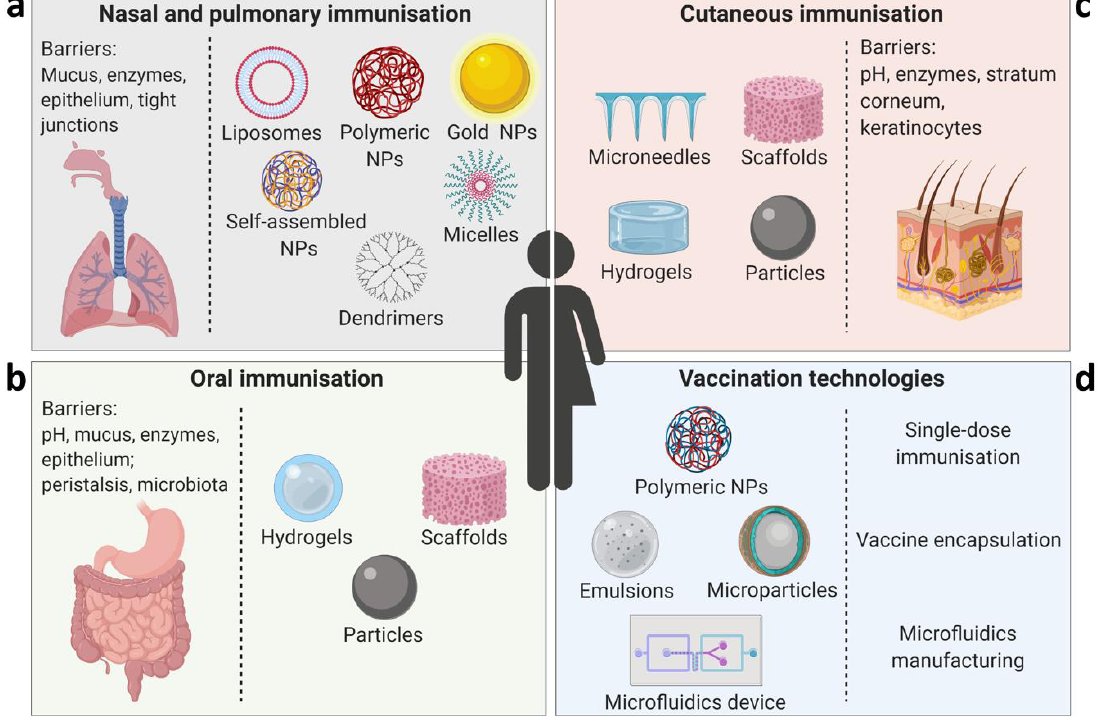
Figure 1. Advanced vaccination technologies and strategies for improving compliance and coverage. Key drug delivery systems to overcome barriers associated with each administration route are presented: ( a ) nasal and pulmonary immunisation using particulate delivery systems such as lipid-based systems (liposomes or nanocapsules), polymeric nanoparticles (NPs), gold NPs, self-assembled NPs (e.g., chitosan), dendrimers, and micelles; ( b ) oral immunisation using delivery systems such as hydrogels, scaffolds, and particles (nano- and microparticles); ( c ) cutaneous immunisation can be performed using microneedles, scaffolds, hydrogels, nano- and microparticles; ( d ) advanced technologies for improving vaccine manufacture and delivery, such as single-dose immunisation using polymeric NPs, and vaccine encapsulation using emulsions or microfluidics systems. Figure prepared using BioRender.